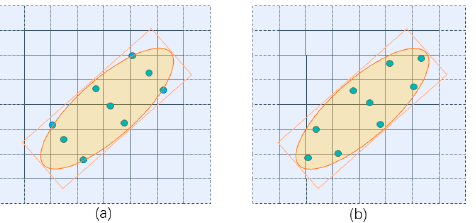
Figure 3. The two sets of sampling locations (blue points). The sampling locations of the RAConv ( a ). The sampling locations of the CAConv ( b ). The orange RB-Boxes indicate the kernels. The yellow ellipses circle the ship areas.